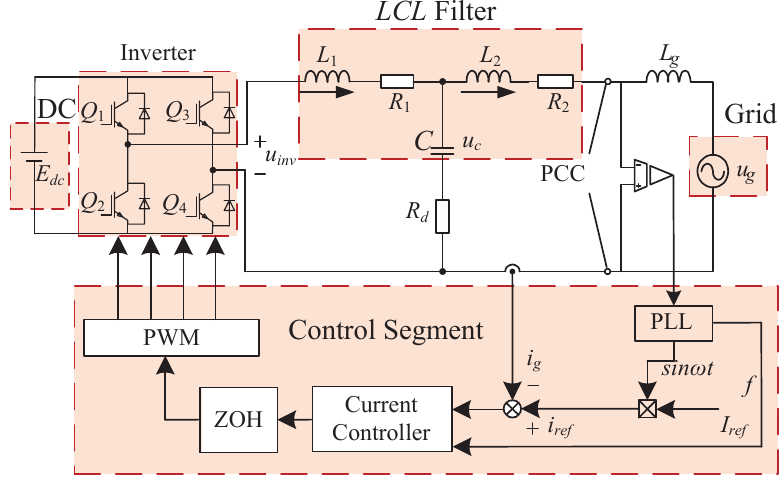
Figure 1. Model structure diagram of a single-phase LCL-type grid-tied